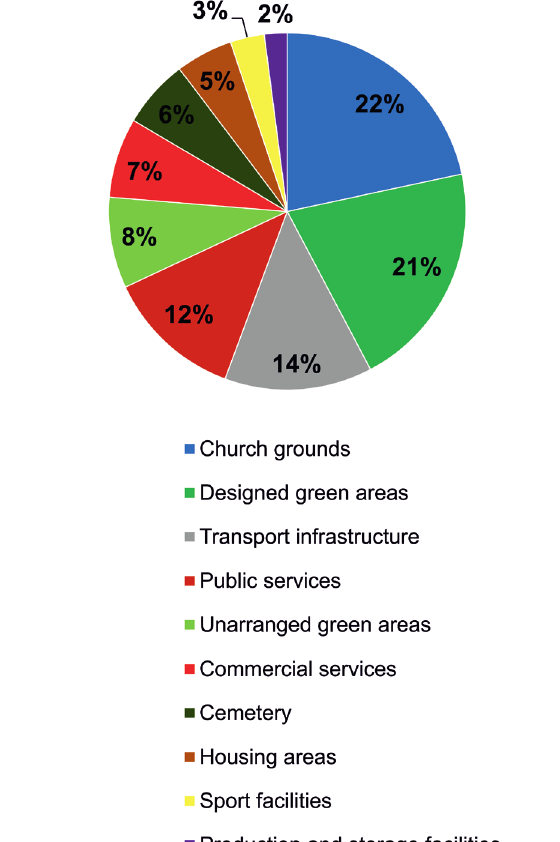
Figure 12. Real and current use of post-cemetery areas according to defined